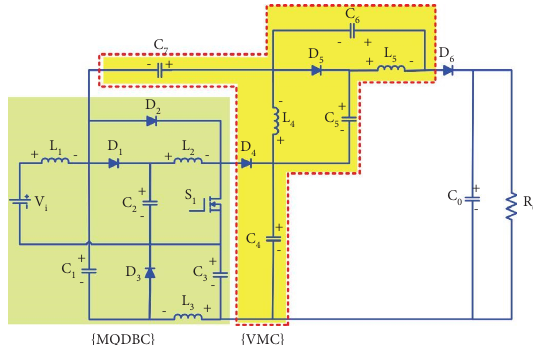
Figure 1: Proposed high gain DC-DC